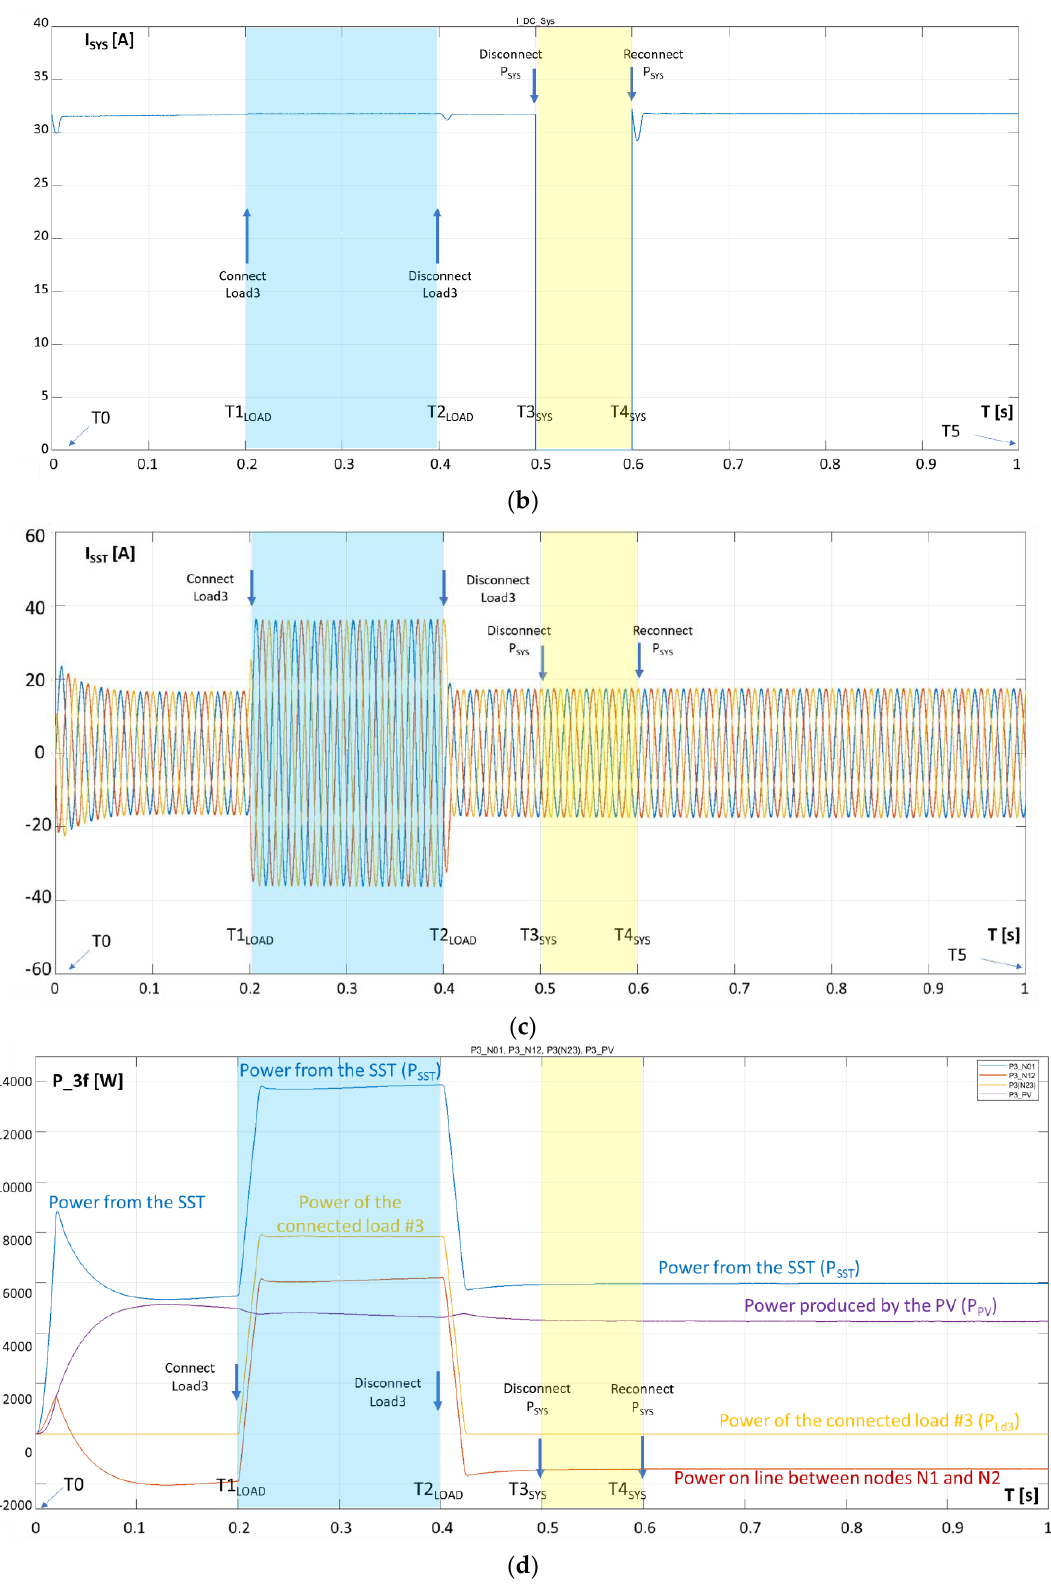
Figure 9. Simulation results in Scenario 2. ( a ) DC bus voltage in the SST; ( b ) Current injected from the main grid in the DC bus of the SST; ( c ) Output currents of the SST (ISST), towards the microgrid (real-time values); ( d ) Active power evolution in different parts of the AC microgrid.